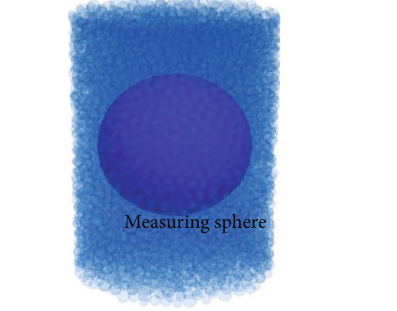
Figure 9: Measuring ball diagram.